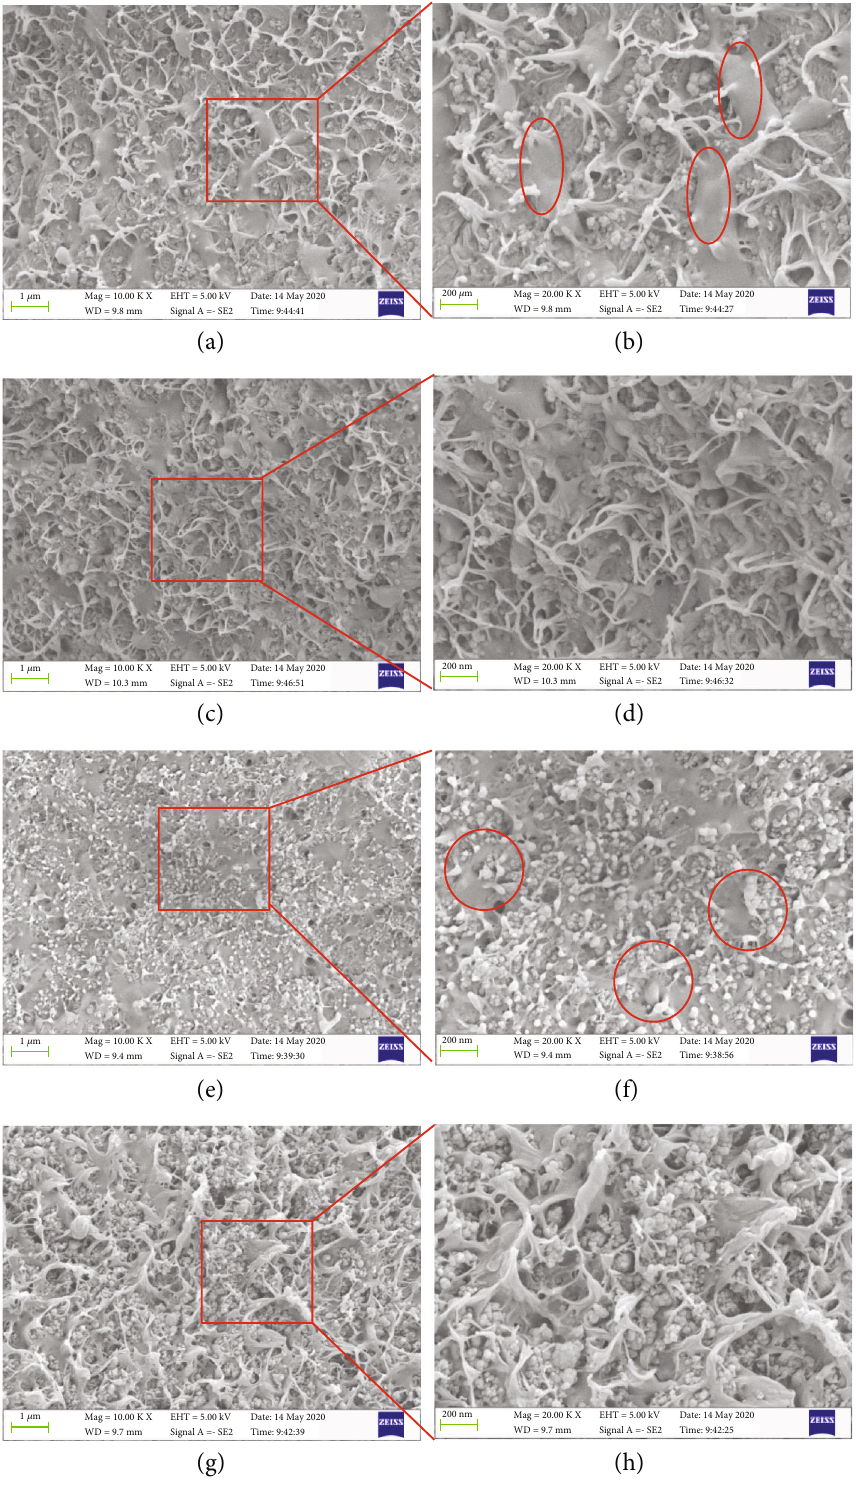
Figure 2: The POE content was fi xed at 18wt.%, SEM images of HDPE/POE/CB with (a) 10wt.% and (c) 30 wt.% CB. The CB content was fi xed at 30wt.%, SEM images of HDPE/POE/CB with (e) 13wt.% and (g) 23 wt.% POE. Images (b), (d), (f), and (h) are the ampli fi cation,